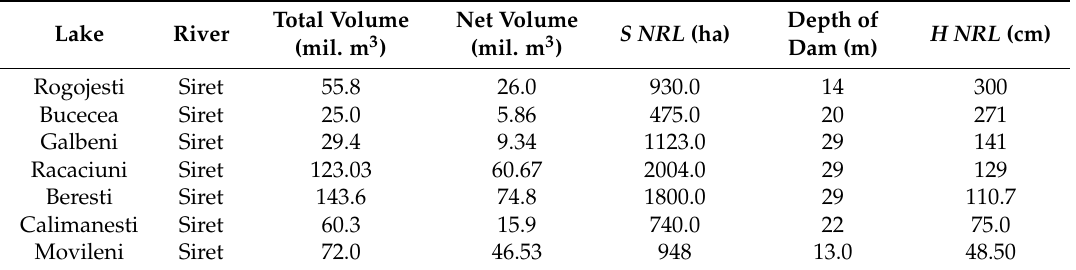
Table 6. Reservoirs on the Siret River with a role in flood